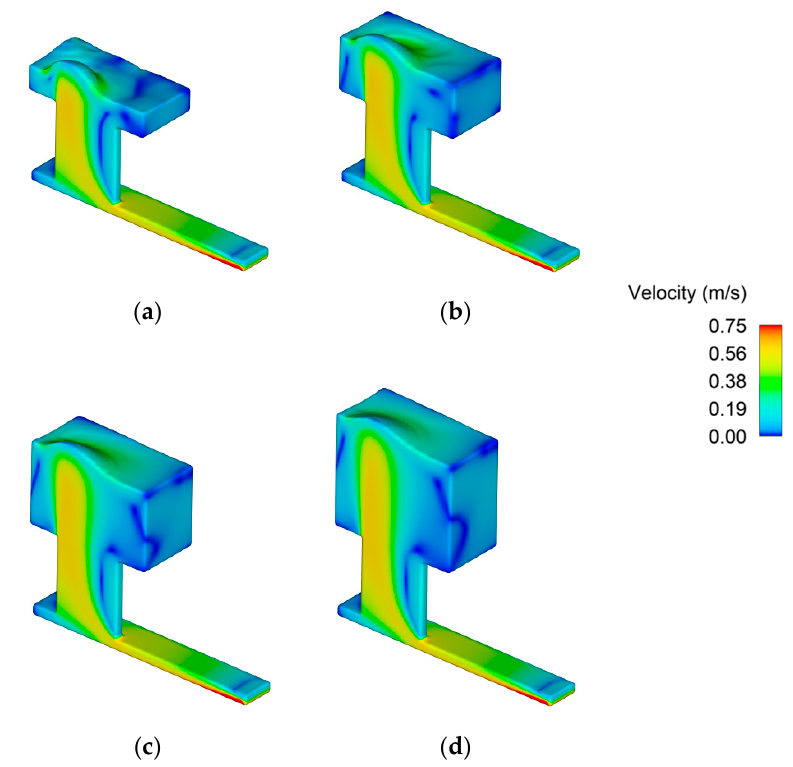
Figure 4. Basic running system (BRS) velocity profiles at ( a ) 1.5, ( b ) 2.5, ( c ) 3.5, and ( d ) 4.5 s.